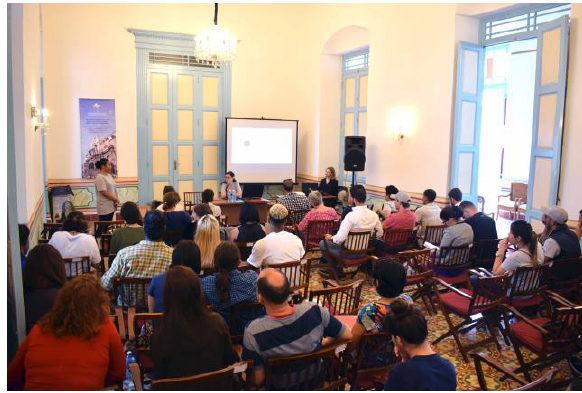
Figure 4. The final seminar at the Conde Cañongo